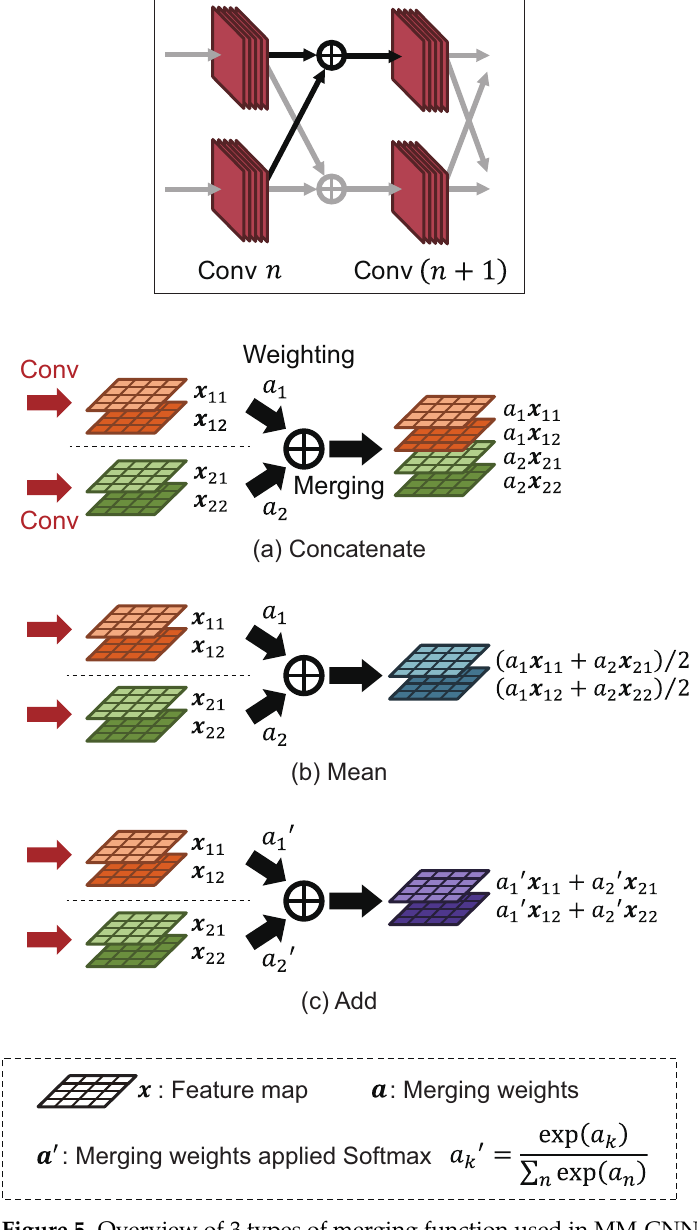
Figure 5. Overview of 3 types of merging function used in MM-CNN. For simplification, both the number of parallels and output channels of convolution layers are set to 2 in this